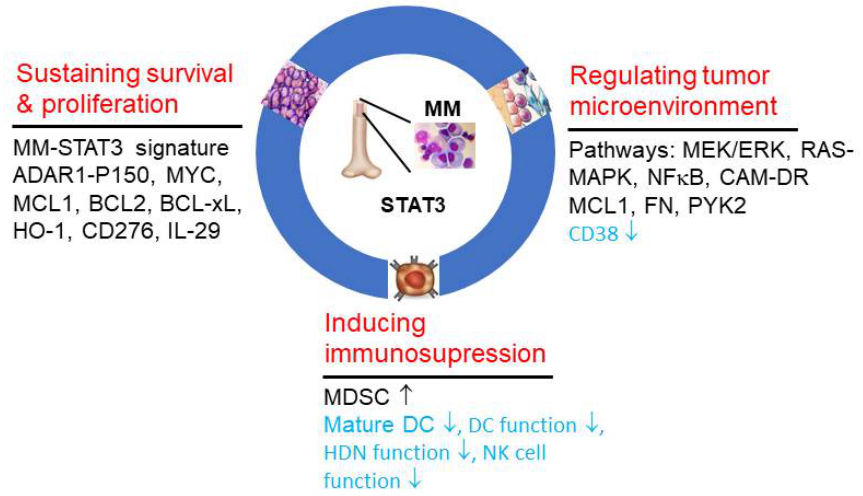
Figure 2. STAT3 regulates the biological hallmarks and enabling characteristics of multiple myeloma. The key mechanisms of action undertaken by STAT3 in facilitating the hallmarks: (1) sustaining MM cell survival and proliferation; (2) regulating tumor microenvironment (bone marrow niche); (3) inducing immunosuppression, and characteristic pathways and essential genes are listed. Genes or pathways in black font represent overexpression or activation, while gene and cell type and function with down arrows in blue font denote decreased expression, or number or function.